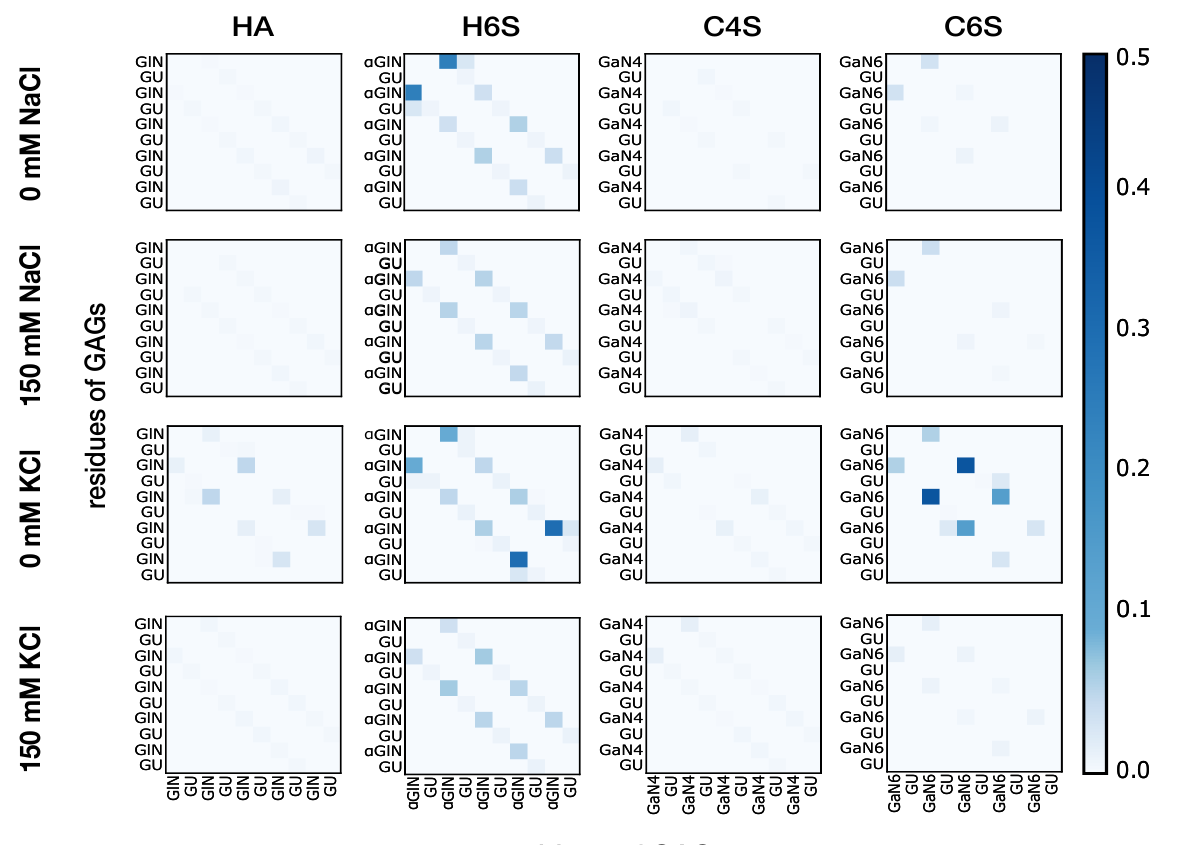
Figure 4. Intramolecular contacts among the residues of the GAGs at 0 mM NaCl, 150 mM NaCl, 0 mM KCl, and 150 mM KCl concentrations (labels left of each panel). The residues of the GAGs are abbreviated with the following codes: GU (GlcUA), GlN (GlcNAc in HA), α GlN (GlcNAc(6S) in H6S), GaN4 (GalNAc(4S)), and GaN6 (GalNAc(6S)). The color code on the right represents the probability of a contact among residues during the MD simulations. For the sake of clarity, the diagonal and first off-diagonal elements of the contact maps corresponding to self-contacts within the same disaccharide unit are not